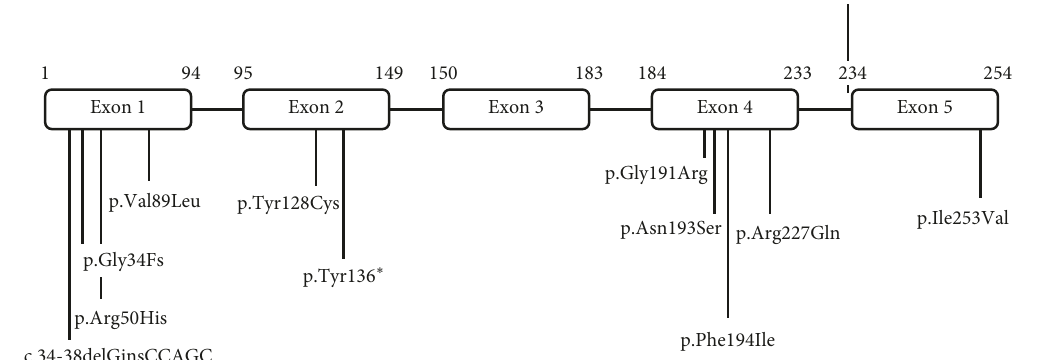
Figure 1: Distribution of the SRD5A2 gene variants identified in 37 cases of 48,XY DSD. Most of the variants are located at exons 1 and 4 of the SRD5A2